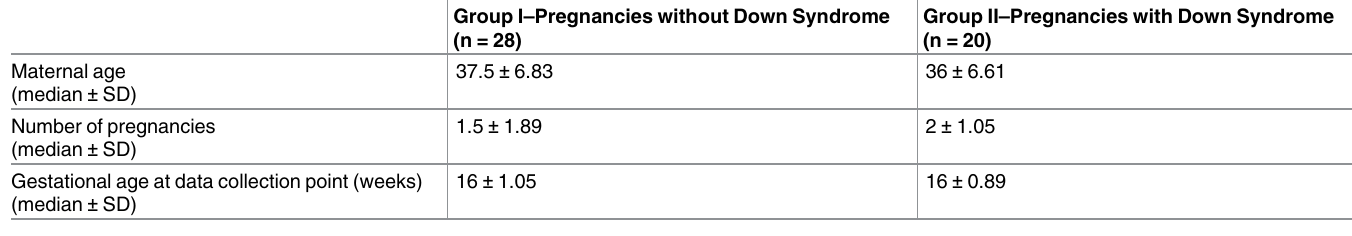
Table 1. Clinical characteristic of the